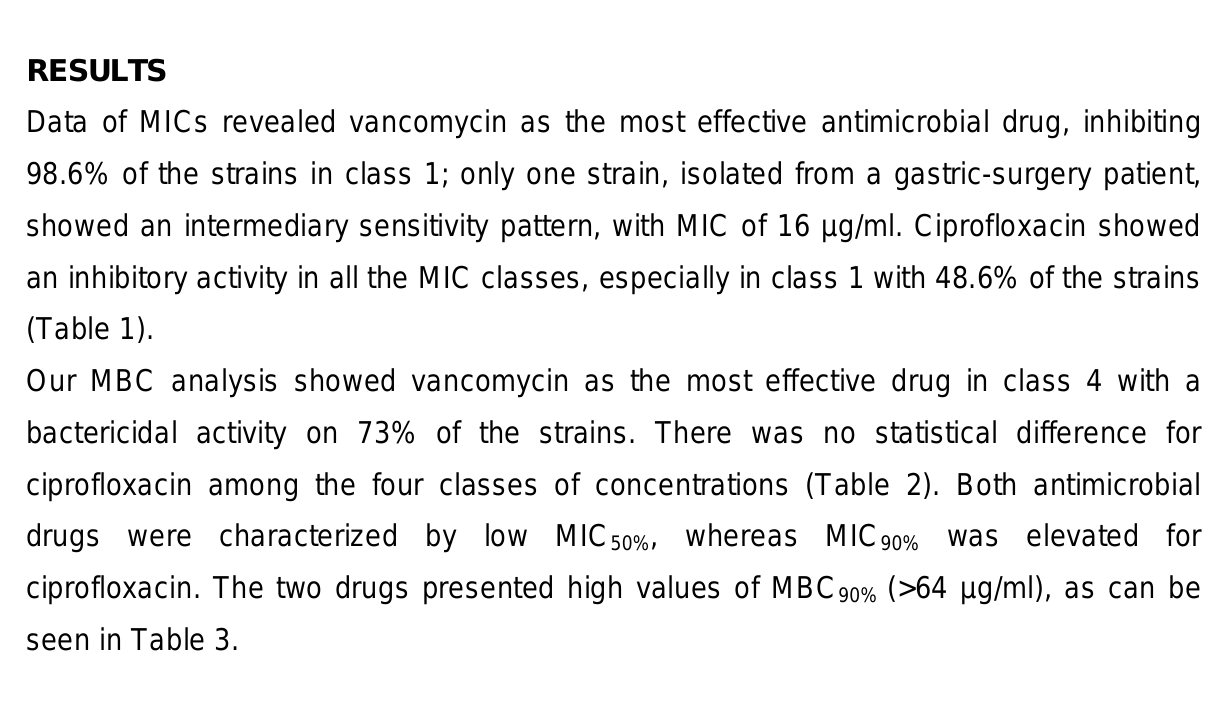
Table 1. Susceptibility of 74 Enterococcus faecalis strains in four classes of MIC ( µ